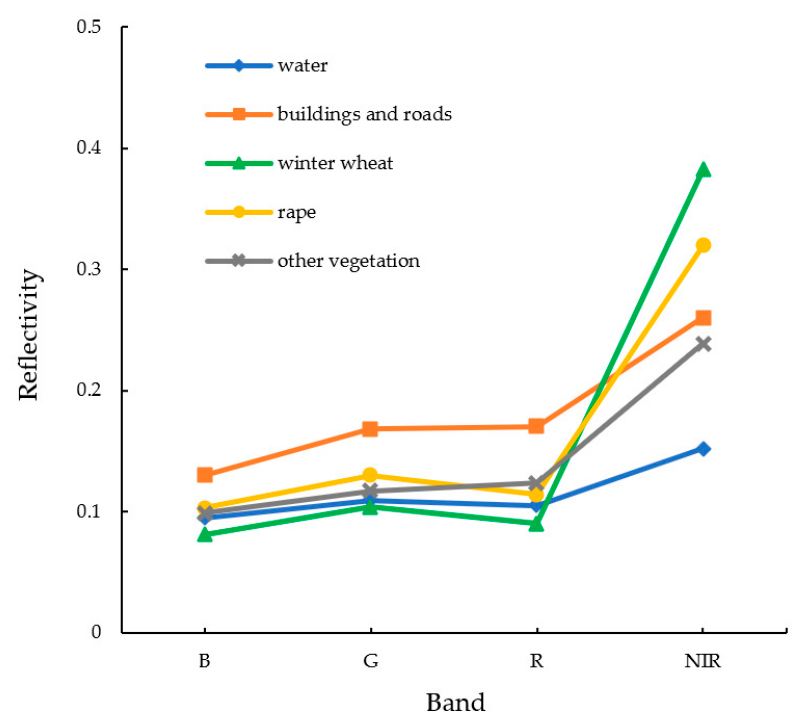
Figure 3. The reflectivity of main objects in HJ satellite image.